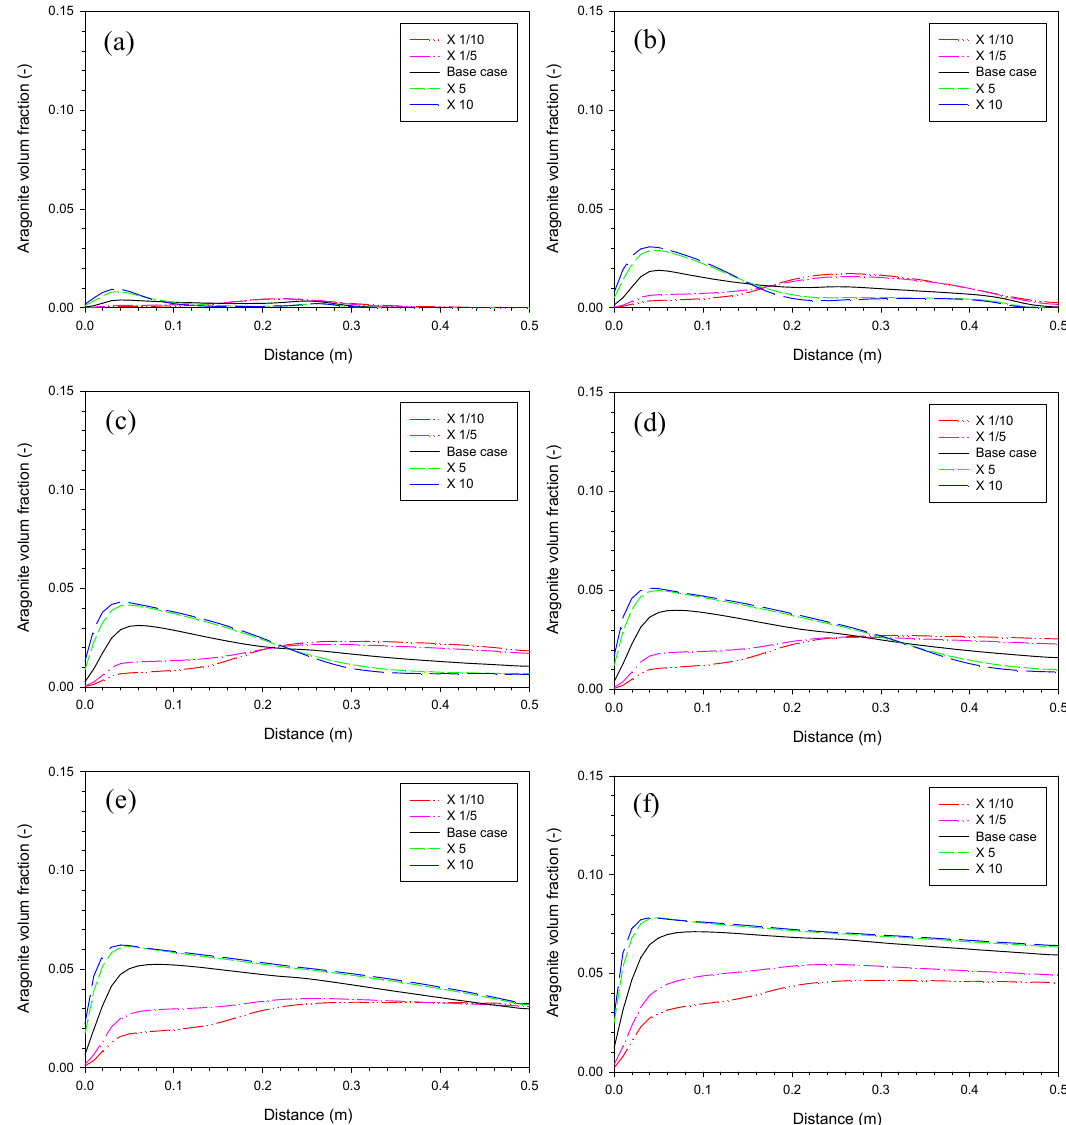
Figure 4. Sensitivity analysis of aragonite precipitation rate. Aragonite volume fraction on ( a ) Day 4, ( b ) Day 25, ( c ) Day 54, ( d ) Day 87, ( e ) Day 164, and ( f ) Day 410 with value of the base case, × 1/10, × 1/5, × 5, and × 10.